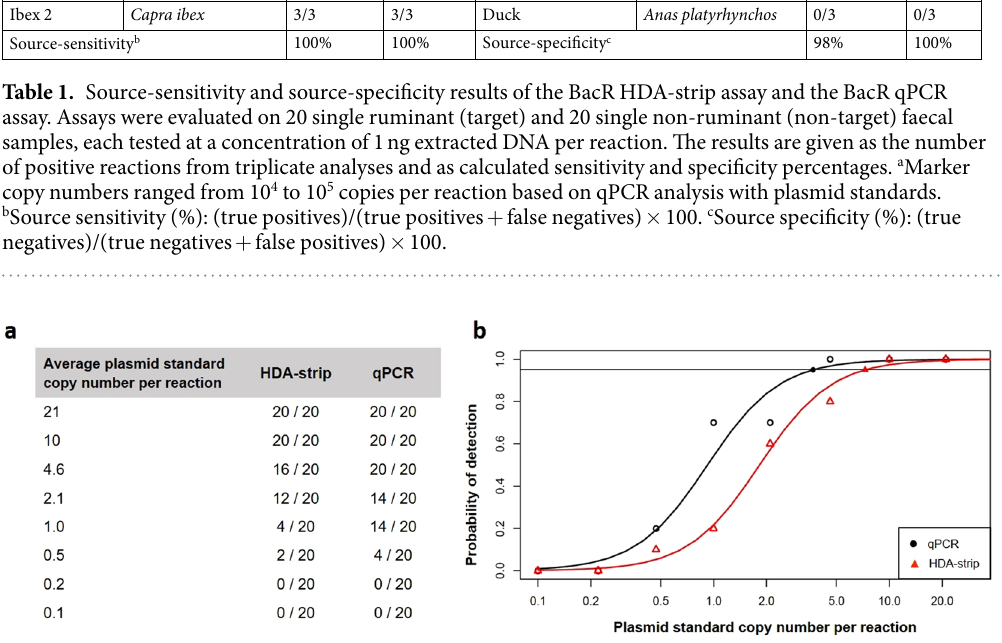
Figure 2. Limits of detection (LOD 95% ). ( a ) Raw data from the analyses of a dilution series of the BacR plasmid standard that served as the input for statistical calculations. ( b ) Logistic regression model used to determine the LOD 95% , which is indicated by filled symbols on the horizontal line. LOD 95% (with 95% confidence interval): HDA = 5.2 ≤ 7.3 ≤ 10.3 copies; qPCR = 2.6 ≤ 3.7 ≤ 5.2